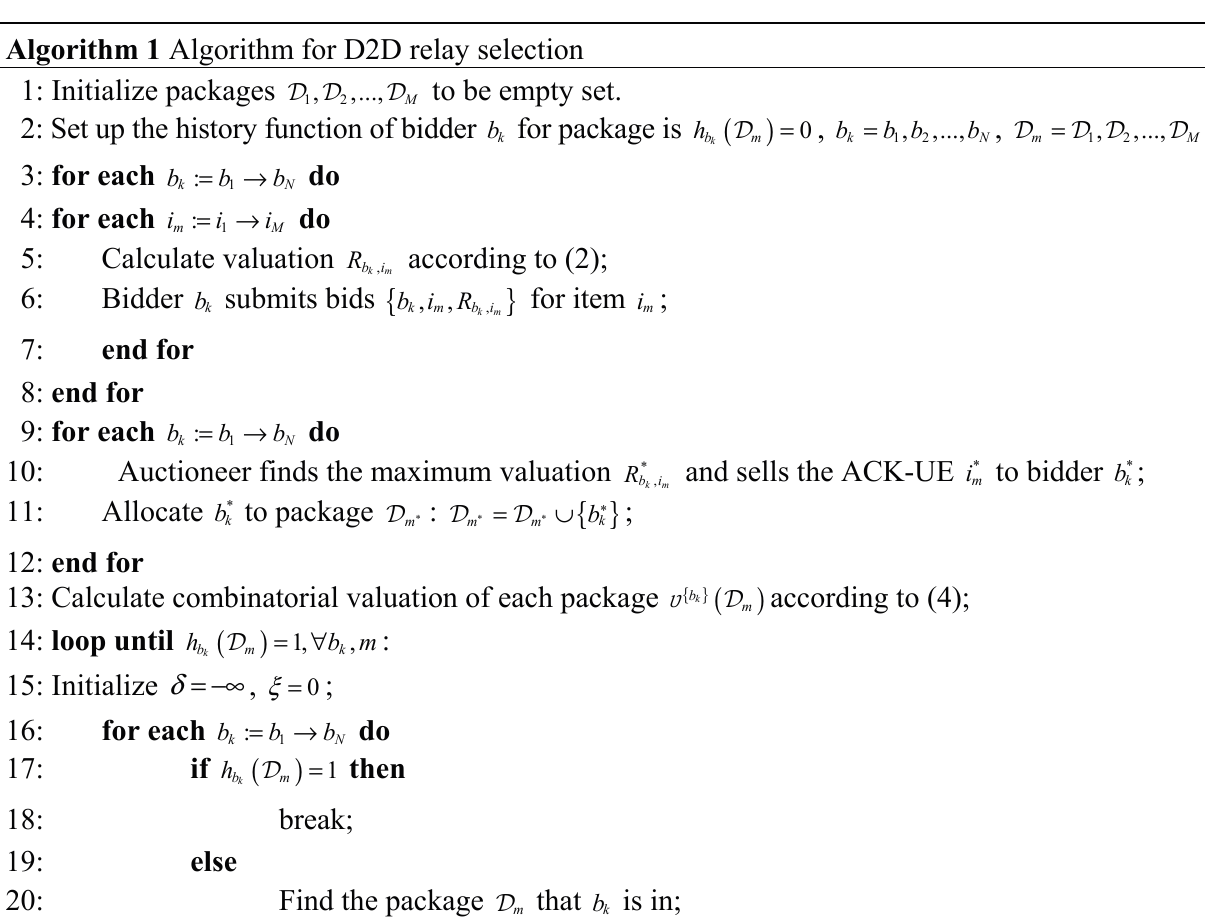
Algorithm 1 Algorithm for D2D relay